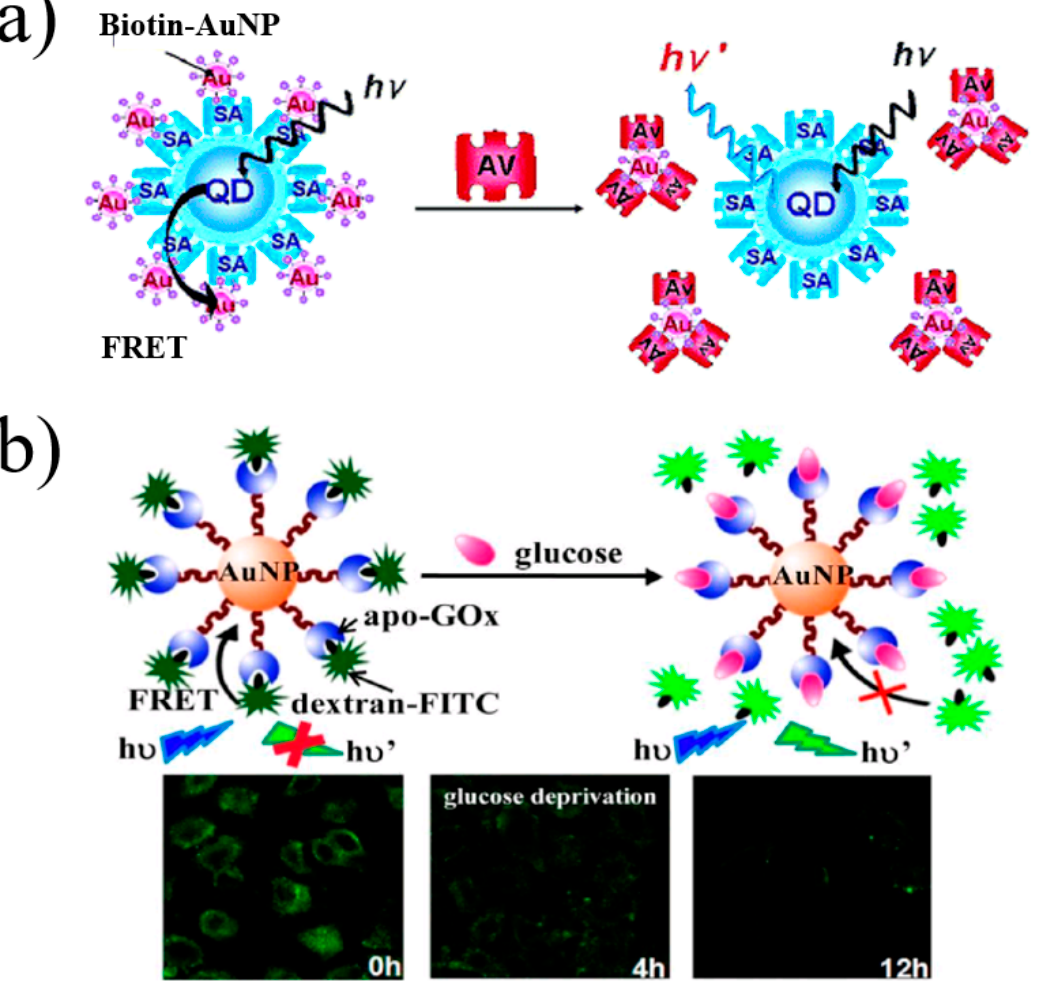
Figure 5. ( a ) Schematic of a method to inhibit the interaction between anti-biotin streptin- conjugated QDs and AuNP-conjugated biomolecules [60]. ( b ) A typical AuNP-apo-Gox-dextran-FITC nanoprobe [61].